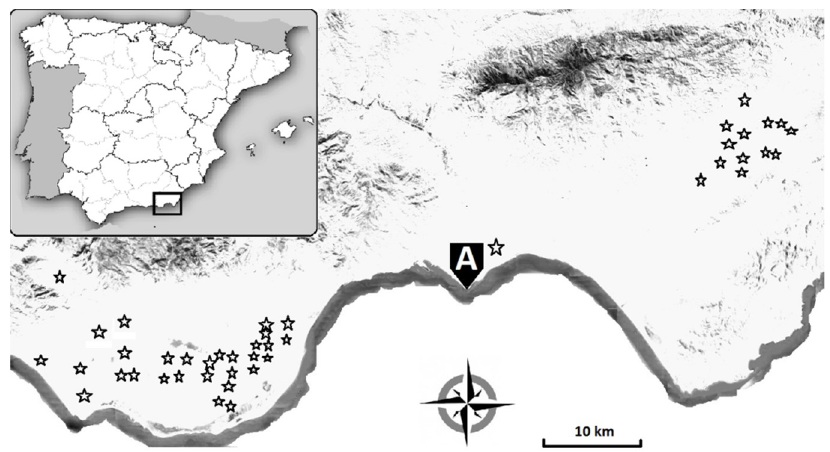
Figure 1. Location of 44 greenhouses surveyed for monitoring whitefly-control strategies during 2015–2018. The survey of tomato leaf curl New Delhi virus (ToLCNDV) was carried out in another 35 zucchini greenhouses in 2017 (not shown). ( A ) Almería city.